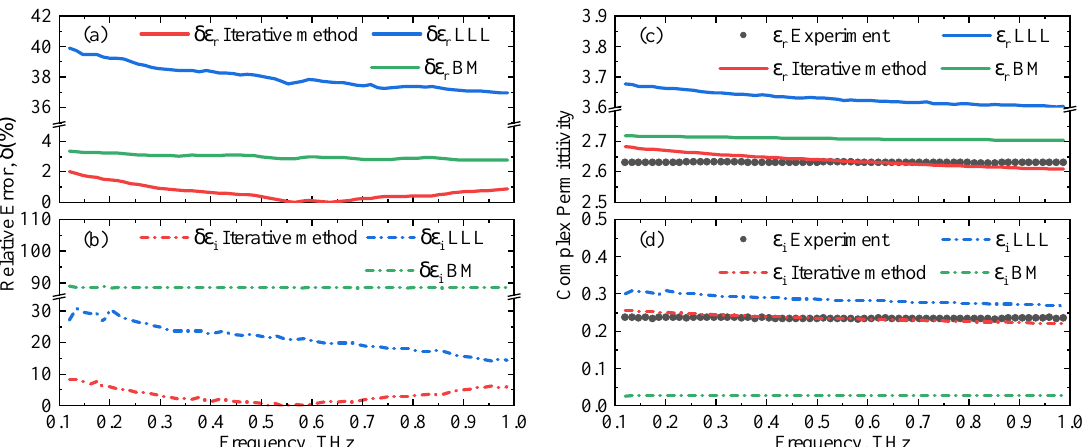
Figure 2. ( a , b ) Comparison of the experimental and simulated effective complex permittivity of TiO 2 Ag/LDPE (LLL—Landau–Lifshitz–Looyenga model, BM—BG model). ( c , d ) The relative errors of the EMT models. Upper—real part of the complex permittivity. Lower—imaginary part of the complex permittivity.